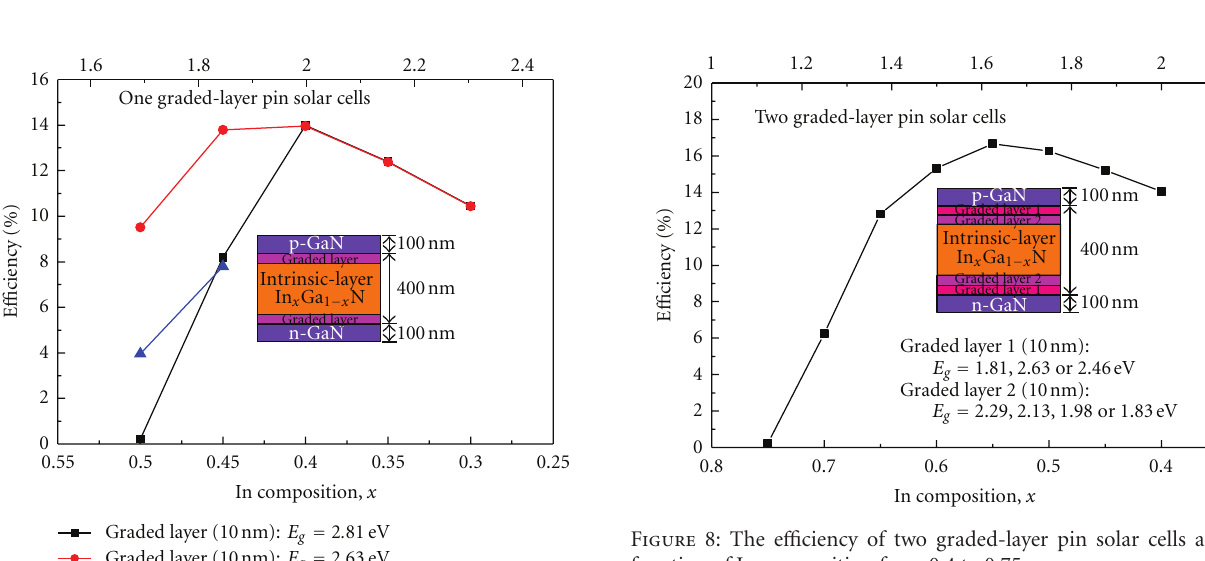
Figure 6: (a) The e ffi ciency of one graded-layer In 0 . 3 Ga 0 . 7 N pin solar cells with four di ff erent graded energy bandgap of 3.01, 2.81, 2.63, and 2.46eV as a function of the graded layer thickness. (b) The energy band diagram of one graded-layer In 0 . 3 Ga 0 . 7 N pin solar cells with four di ff erent graded energy bandgap of 3.01, 2.81, 2.63, and 2.46 eV.